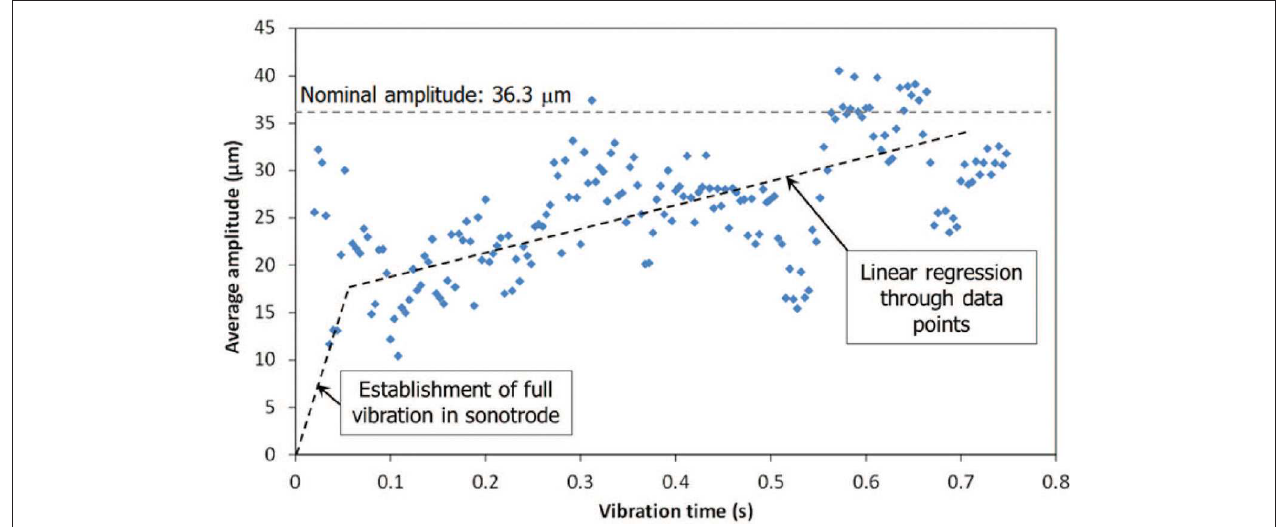
FIGURE 3 | Estimated amplitude of vibration transmitted to the top adherend during ultrasonic welding of CF/PEI single-lap coupons (welding force 1,500N, peak-to-peak vibration amplitude 2 × 36.3 µ m) as measured with laser sensor 2mm away from the sonotrode. Note that the amplitude values represented in the graph are half of the peak-to-peak amplitude values. Reprinted from Palardy et al. (2018) with permission from Elsevier.